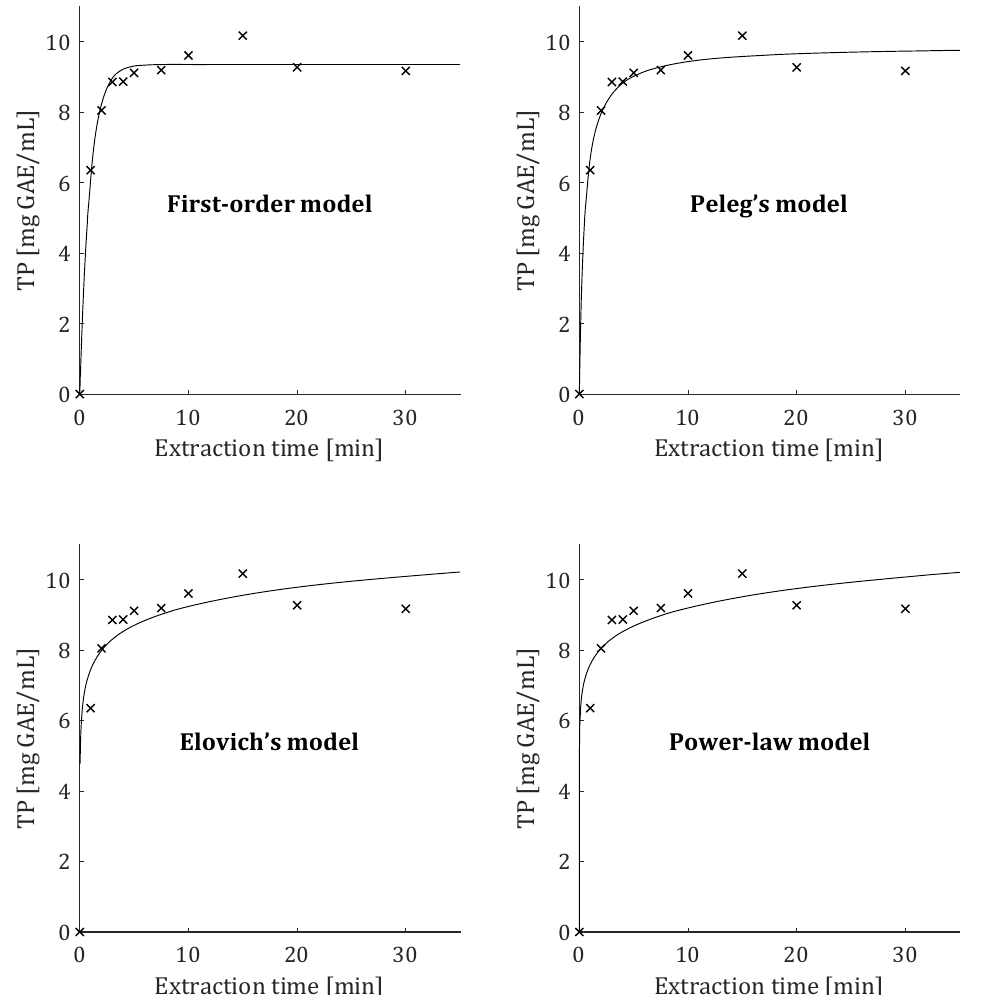
Figure 5. Experimental data and fitting curves of TP observed at 360 W for four kinetic models.